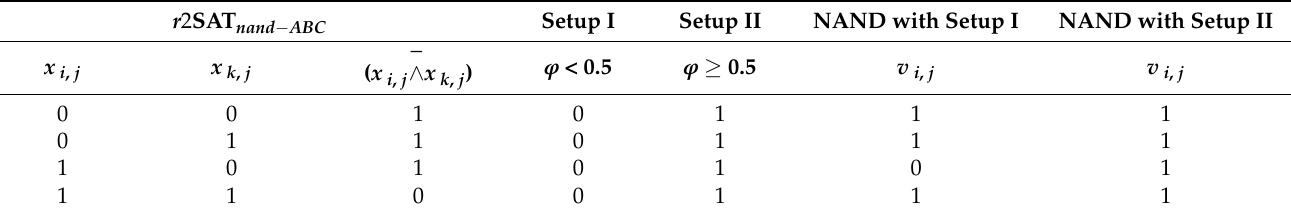
Table 7. The implication truth table for NAND.